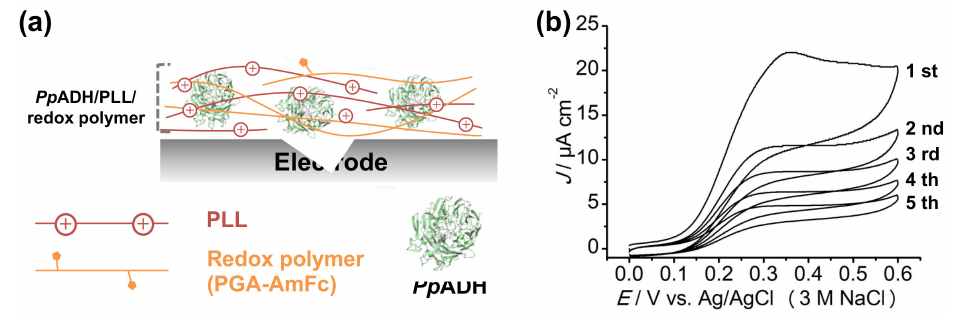
Figure 6. ( a ) Schematic illustration of the Pp ADH-modified glassy carbon electrode with the cationic polymer (PLL) and PGA-AmFc. ( b ) Cyclic voltammograms of the Pp ADH, PGA-AmFc